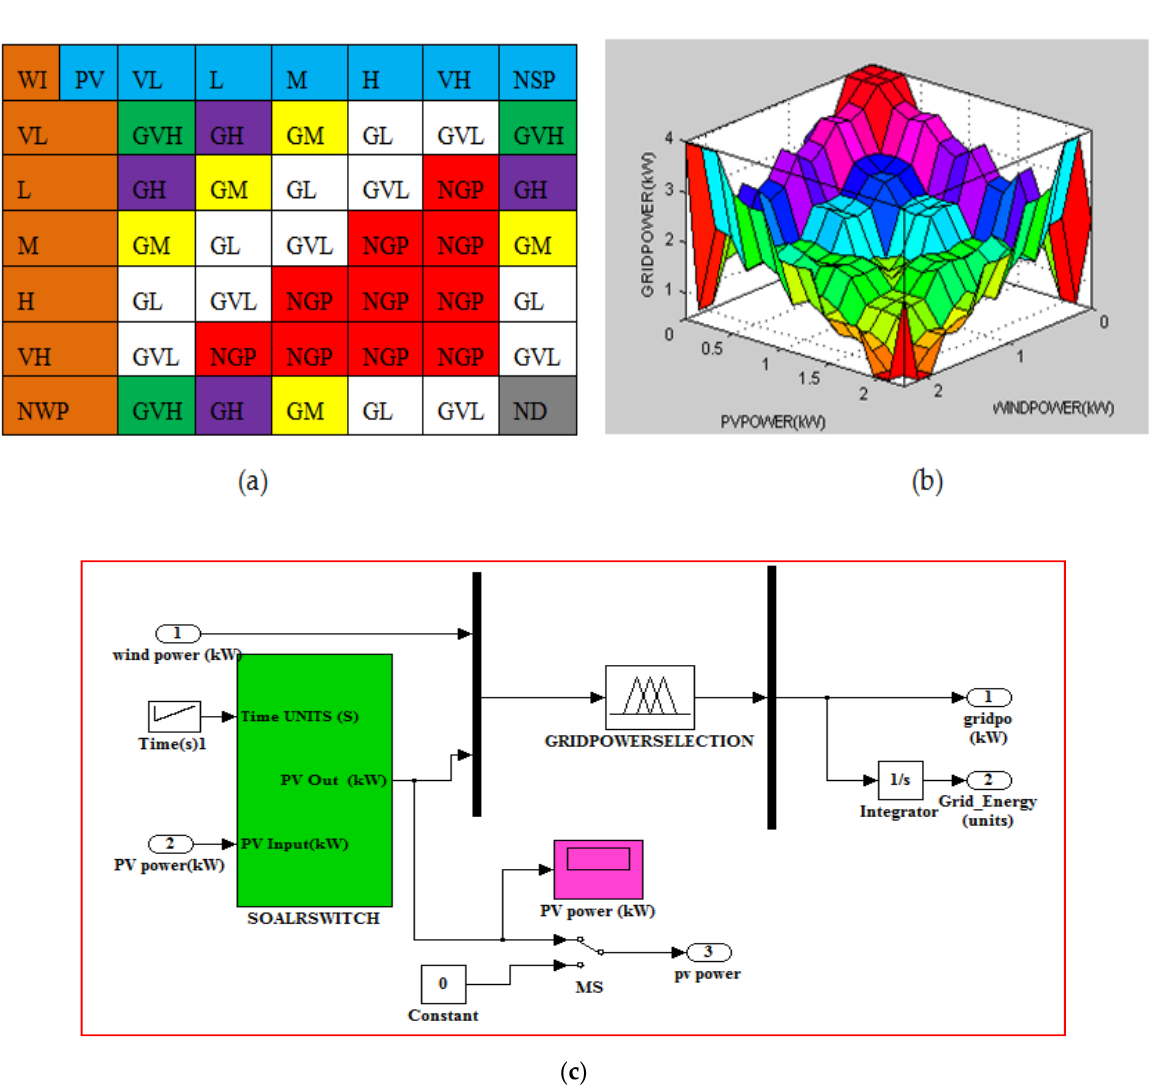
Figure 10. Grid power selection switch description ( a ) IF-THEN rules table ; ( b ) GPS surfaces ( c ) GPS with PV and wind energy output blocks in Simulink.